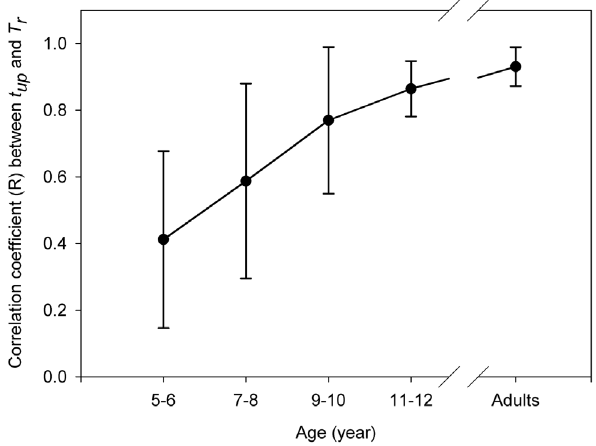
Figure 6. Information-movement coupling. Correlation coefficient ( R c ) between duration of the ball upward motion ( T up ) of the ball and the period of racket oscillation ( T r ) for the 5 age groups. The mean standard deviation R c for each age group is represented by error bars.